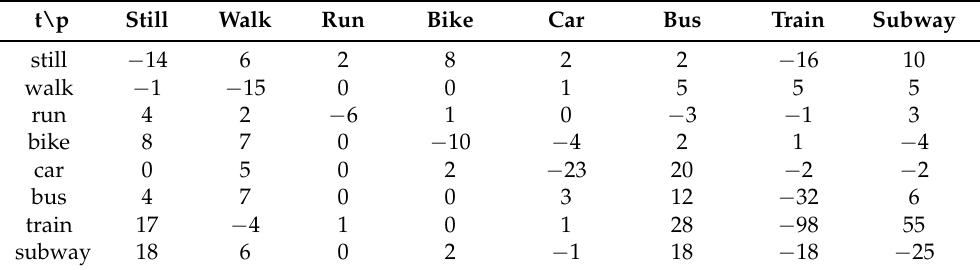
Table 4. The difference confusion matrix of the network trained without the acceleration sensor. The largest loss in classification occurred in the class bus and the smallest in class run . t = true label, p = predicted label.